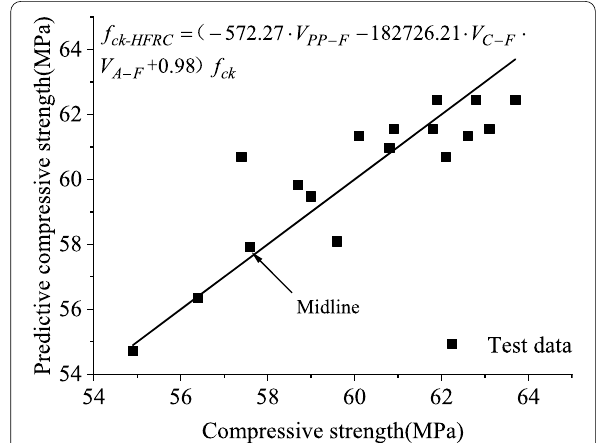
Fig.10 Comparison of experimental values and predictions. The test datum of each point is derived from the average of three